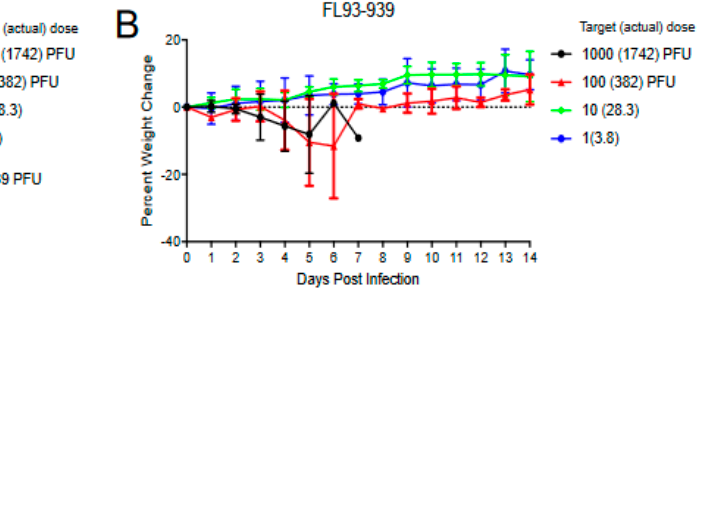
Figure 8. Survival curves ( A ) and weight loss ( B ) for 4–week–old CD–1 mice infected subcutaneously with 1000 PFU of each indicated virus. Experiments included 5 or 10 animals per group and were performed at least twice with similar results. Error bars are standard deviations. LD 50 Fl93–933 vs. V105 not significantly different.